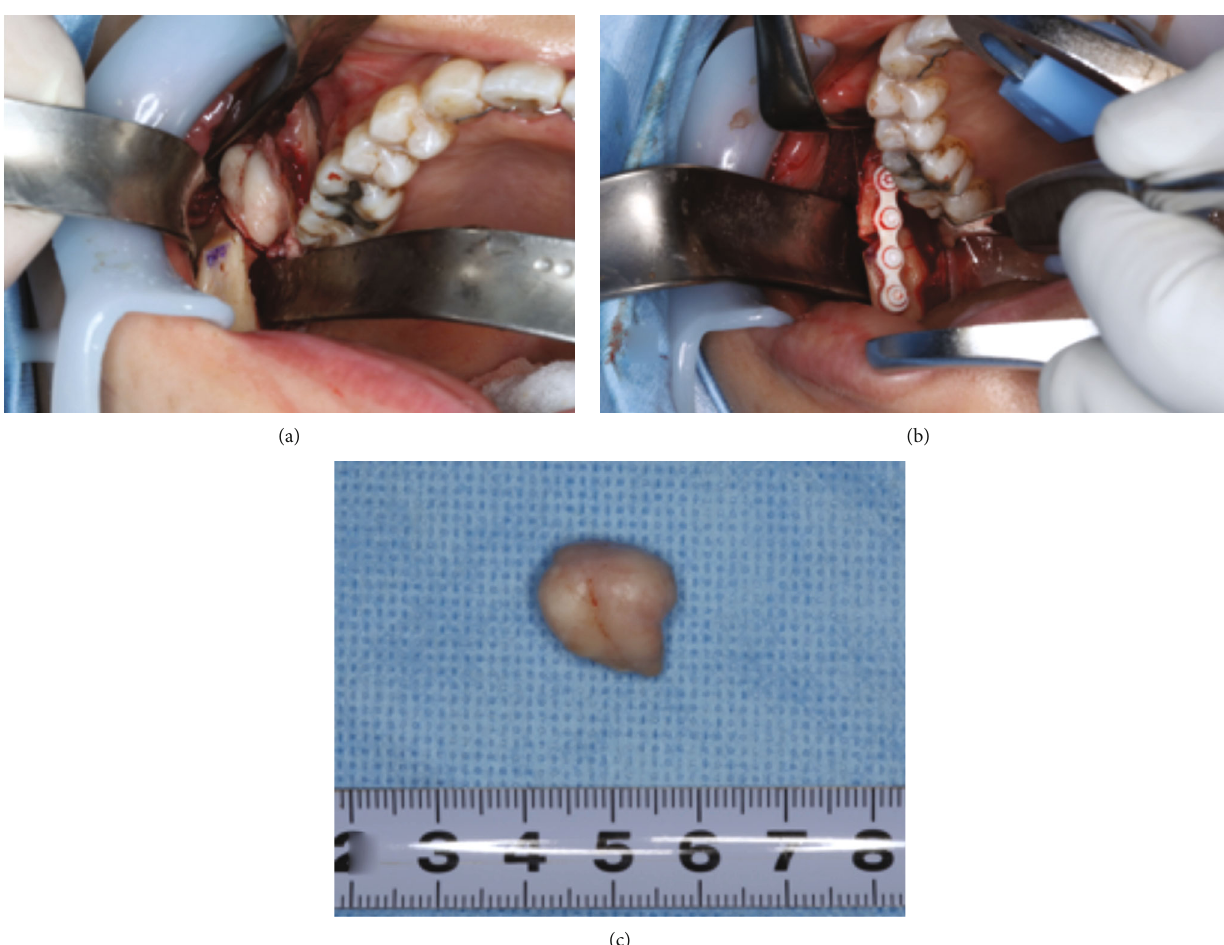
Figure 4: Intraoperative view. (a) The lesion was exposed by an intraoral approach. (b) The myoprojection was temporarily dissected, and the bone was repositioned and fi xed with an absorbent plate. (c) Excised osteoma.